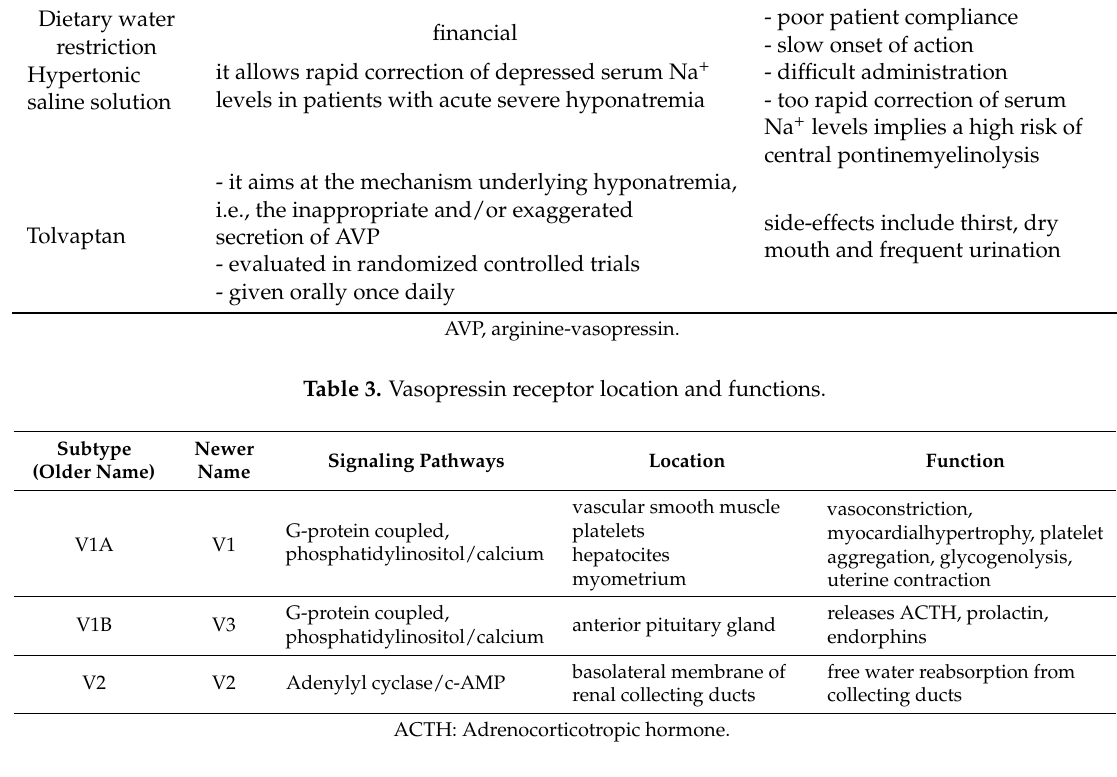
Table 4. Classification of vasopressin receptor antagonists